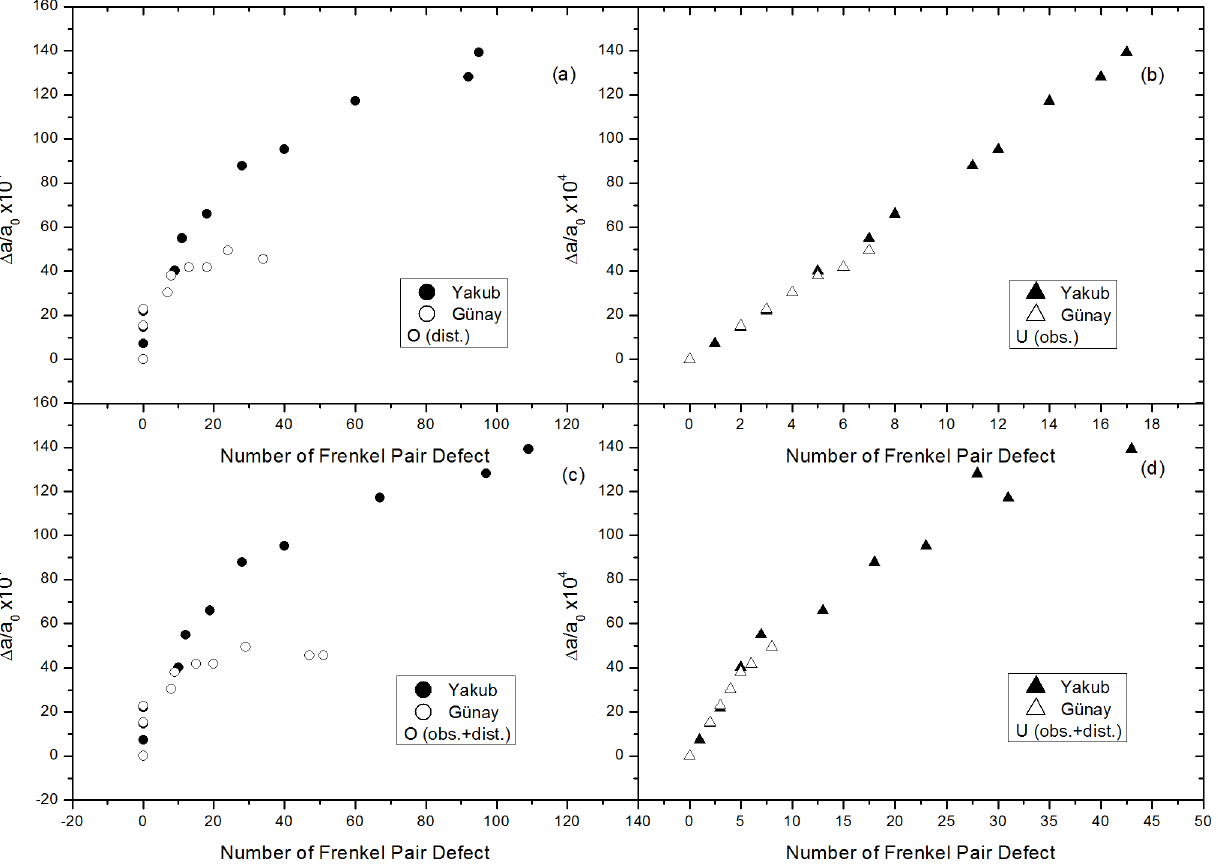
Fig 7. Relative lattice expansions of different types of defects: circles indicate oxygen, triangles uranium. (a) Oxygen distortions (b) uranium obstructions (c) oxygen obstructions + distortions and (d) uranium obstructions + distortions.